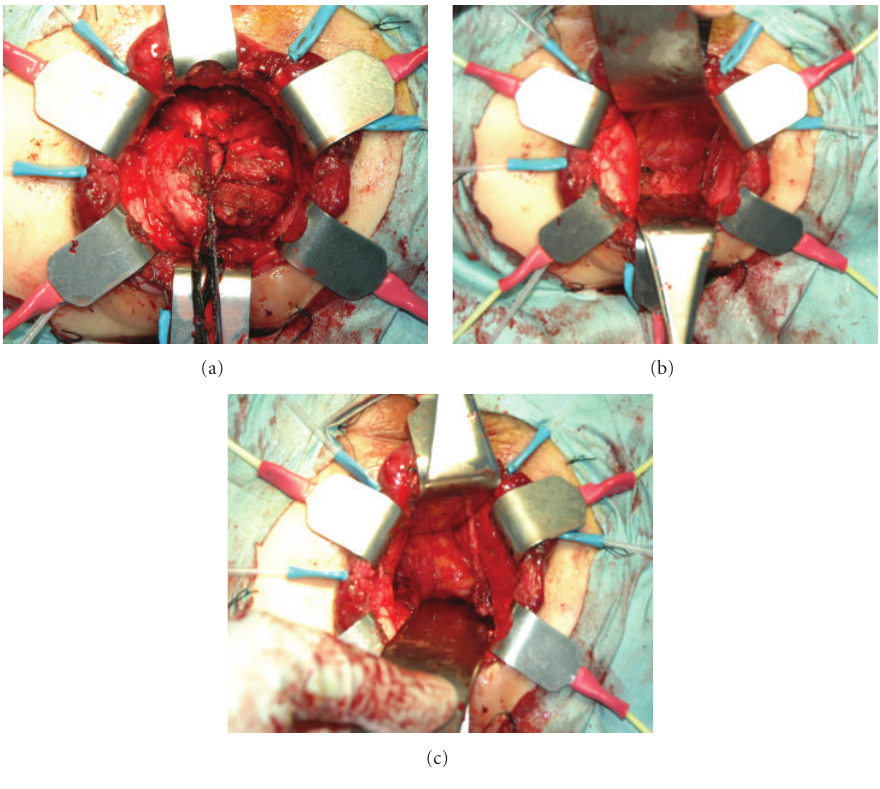
Figure 1: Transanal rectal dissection for a male patient with T3 low rectal cancer. A circular incision of the rectum was performed by closing the cut end of the rectum (a). The rectum including the tumor was mobilized proximally by exposing the levator ani (b,